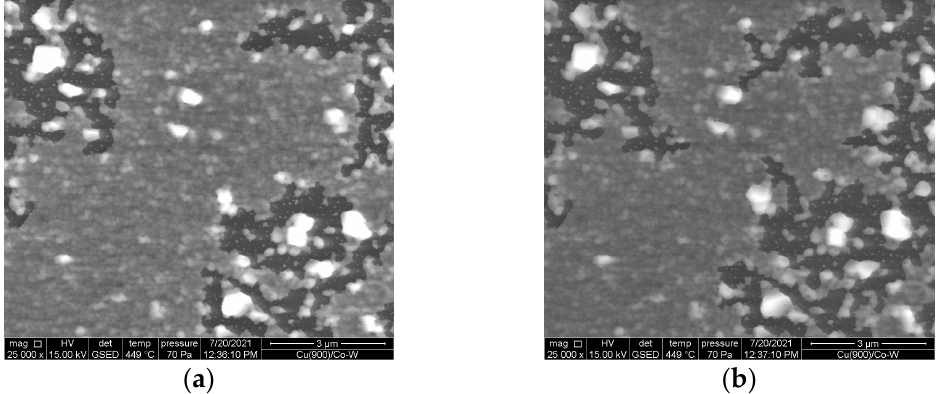
Figure 3. Dewetting progression of a Cu film with a Co-W substrate during a 1-min time-lapse, at 450 °C, heated at 10 °C/min ( a ) after 127 min. and ( b ) after 128 min. total annealing time.